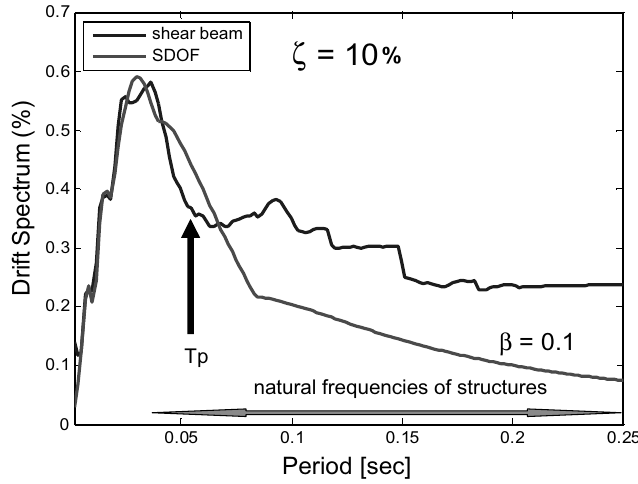
Fig. 4. Drift spectrum for the SDOF and the uniform shear-beam models. The associated waveforms are displayed on the left side of Fig. 2. SDOF drift spectra significantly underestimate maximum deformation for the period range larger than T p . motion period, T p . For periods range larger than T p a significant differences between two models are observed. This indicates that the approximation given by Eq. (4) does not adequately model a structural drift for periods larger than T p [3] show that Iwan’s drift spectrum can be replaced with multi-modal approach using several modes. However, the Eq. (4) is utilizing only the fundamental